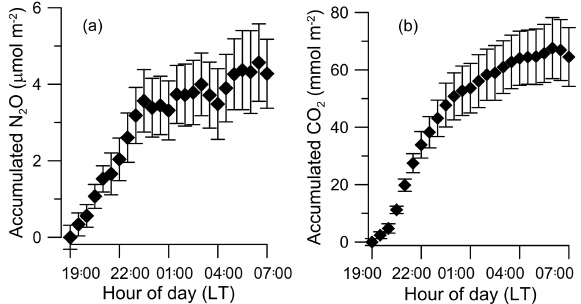
Figure 6. Accumulation of CO 2 and N 2 O within the lowest 6.3m of the boundary layer during the night throughout the study period. The mean accumulations of N 2 O (a) and CO 2 (b) are indicated with vertical error bars, indicating the standard error of the mean of each 30min mean accumulation. Sunrise was approximately 06:00 to